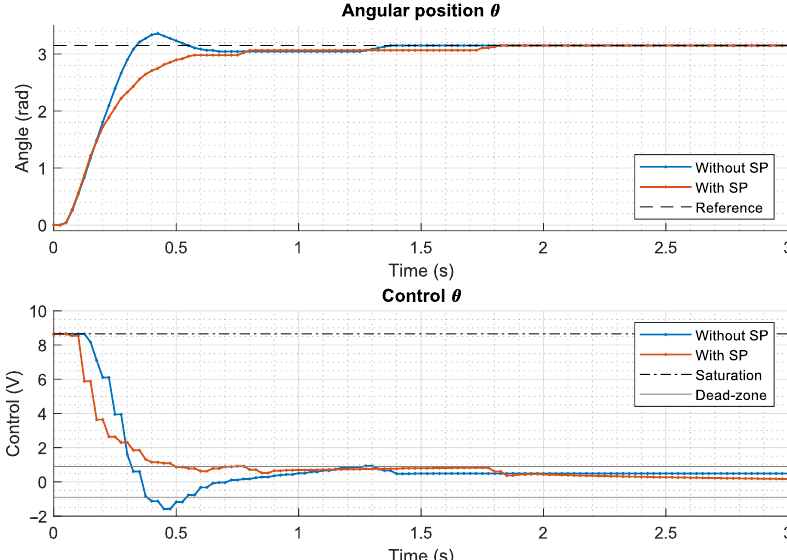
Figure 18. Back-right wheel experimental results with and without Smith predictor.